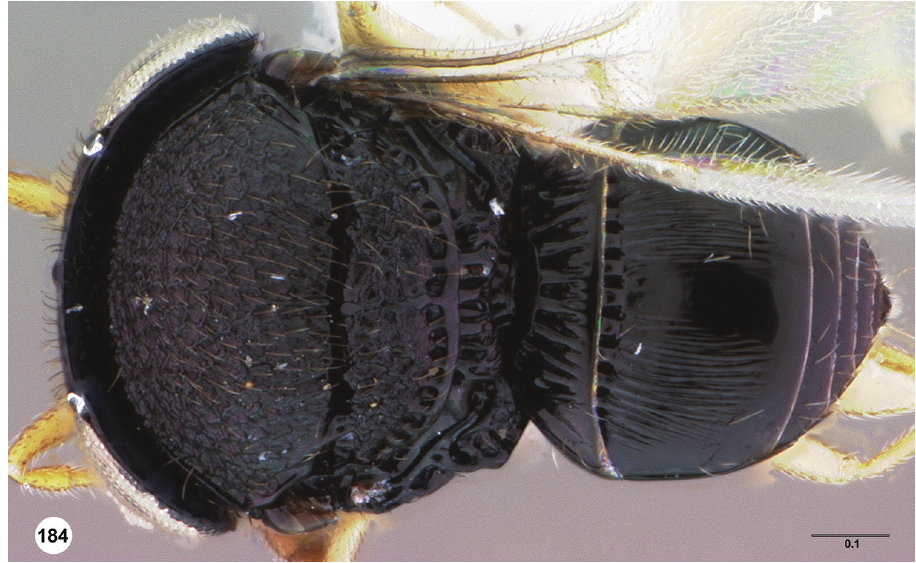
Figure 184. Trissolcus stoicus , female (OSUC 285262), head, mesosoma, metasoma, dorsal view. Scale bar in